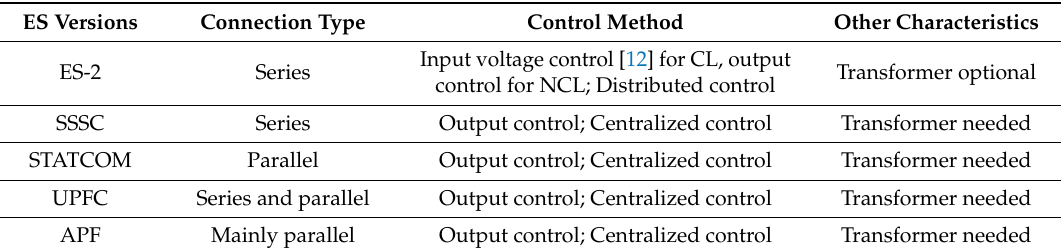
Table 3. Brief comparisons between FACTS devices and single-phase